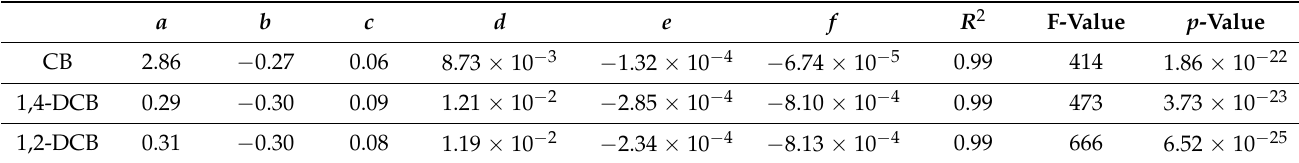
γ j to Equation (6). The statistical parameters were j